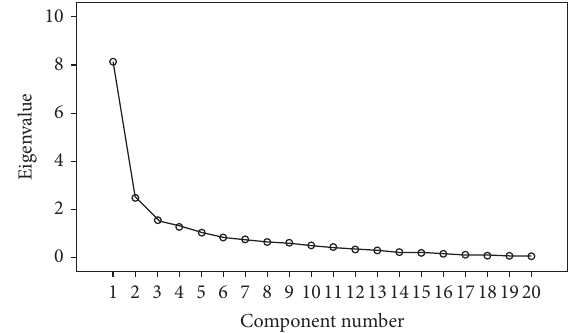
Figure 1: Scree plot of the